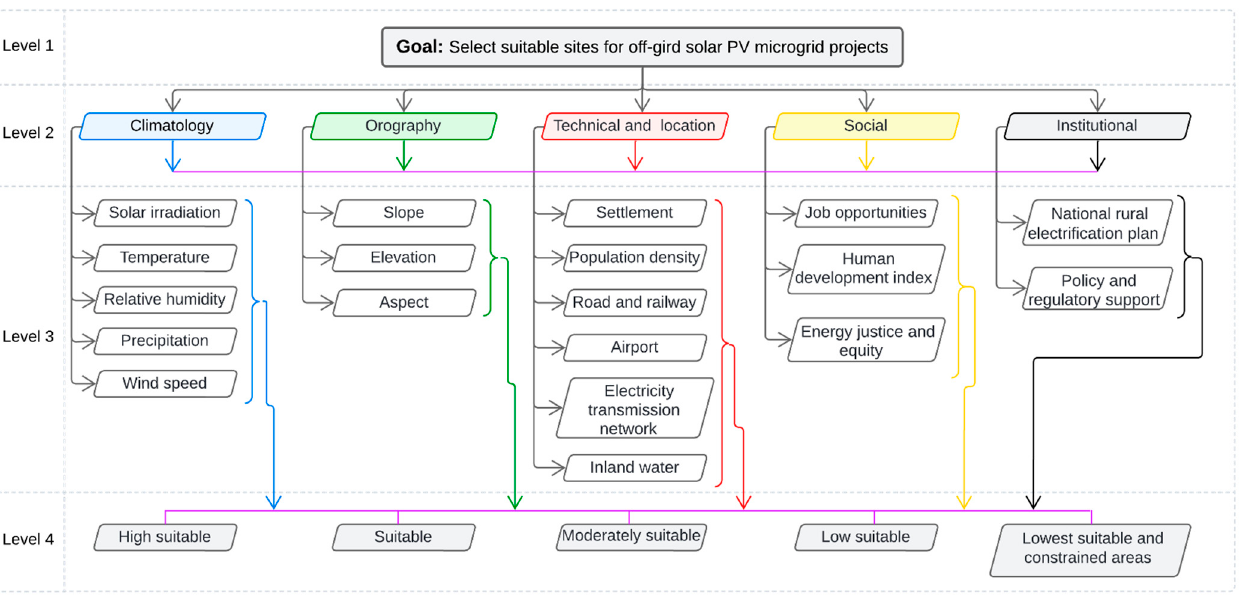
Figure 9. Hierarchy of criteria applied to the AHP for siting off-grid solar PV microgrid projects.